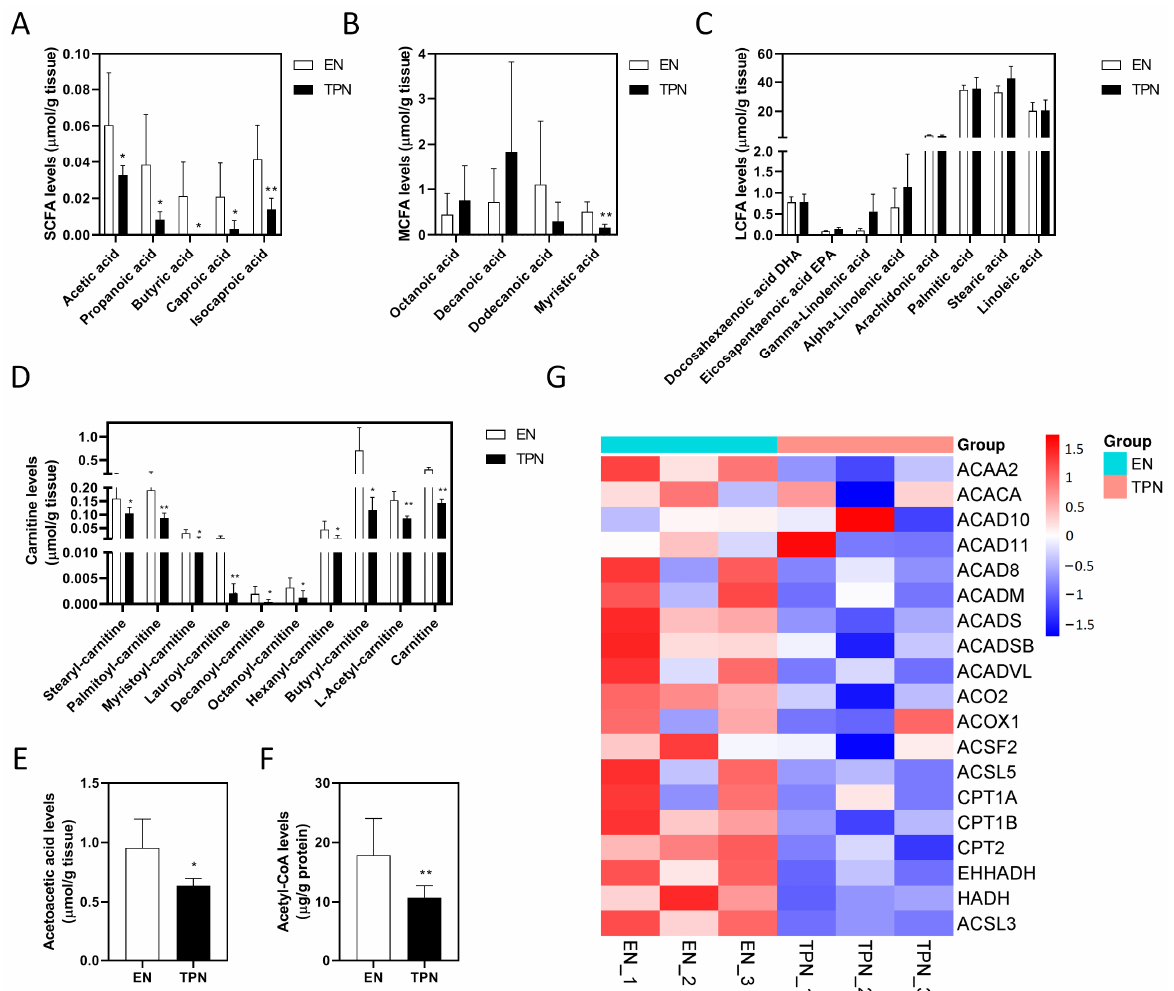
Figure 5. Changes in the metabolomic and proteomic profiles of fatty acid oxidation (FAO). ( A ) Tissue levels of short chain fatty acids (SCFA). ( B ) Tissue levels of medium chain fatty acids (MCFA). ( C ) Tissue levels of long chain fatty acids (LCFA). ( D ) Tissue levels of fatty acylcarnitines. ( E ) Tissue levels of acetoacetic acid. ( F ) Tissue levels of acetyl-CoA. Data are presented as mean ± SD. * p < 0.05, ** p < 0.01 ( n = 5–6/group). ( G ) Heatmap of proteins involved in FAO.